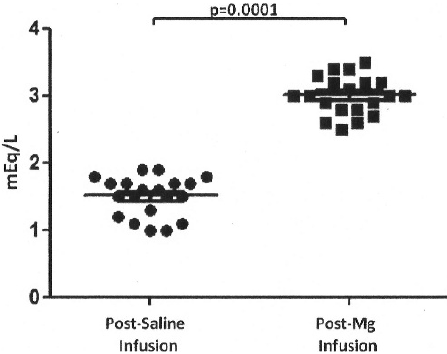
Figure 1 - Mg plasma levels after infusion of 2 g of magnesium sulfate or saline in 20 male